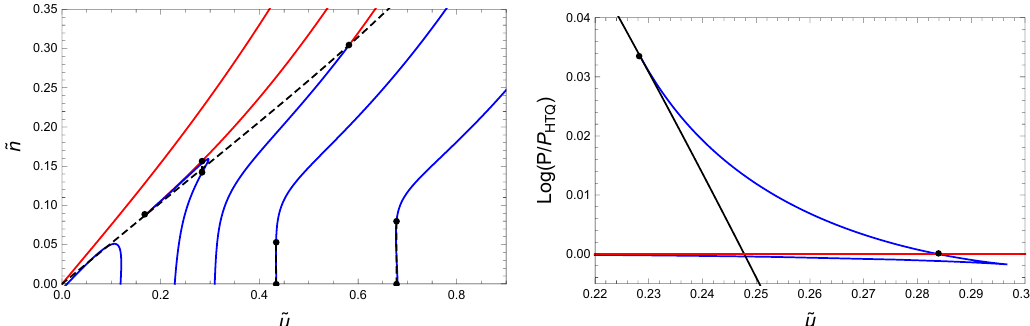
Figure 4 . Left panel: baryon density ~ n as a function of the chemical potential ~ (cid:22) for (cid:12)xed tem- peratures ~ t = 0 ; 0 : 12 ; 0 : 15 ; 0 : 168 ; 0 : 185 from right to left. The dashed curve shows where LTQ and HTQ curves connect | they do so for nonzero but not too large temperatures. The (barely visible) dashed vertical segments for the ~ t = 0 ; 0 : 12 curves indicate a discontinuity due to a (cid:12)rst-order phase transition. Right panel: pressure normalized by that of the HTQ phase as a function of ~ (cid:22) for one of the temperatures of the left panel, ~ t = 0 : 168, that shows a (cid:12)rst-order phase transition between LTQ and HTQ phases. For all curves the mass parameter is ~ (cid:11) = 0 :